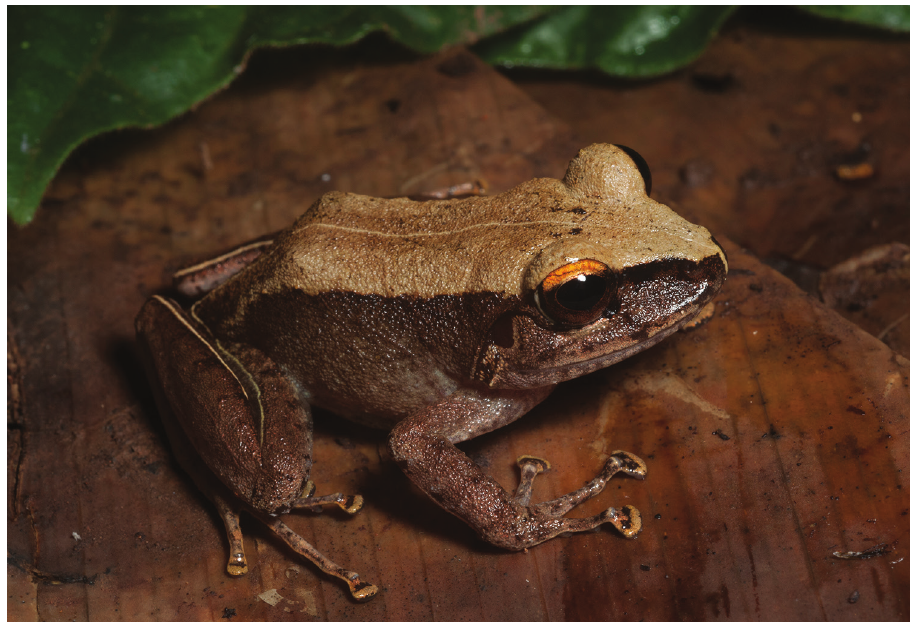
Figure 6. Platymantis cf. guentheri sp. male 1 (KU 333536) from May-Impit, Mt. Hilong-hilong, Mu- nicipality of Remedios T. Romualdez, Agusan del Norte Province. Photo: